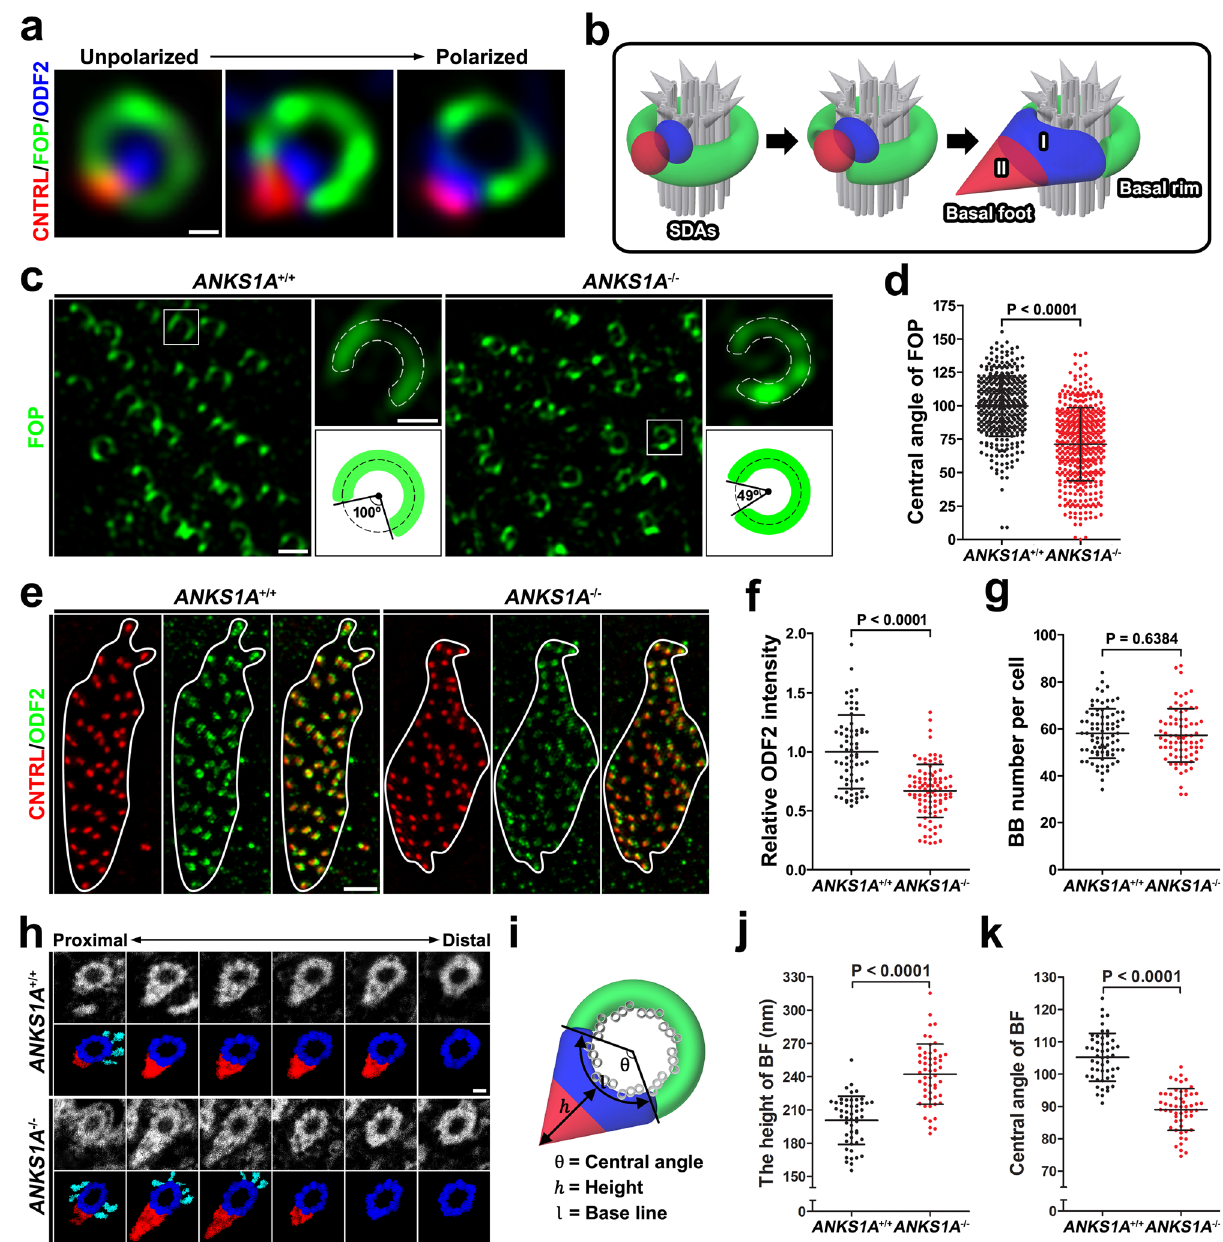
Fig. 2 ANKS1A loss results in partially impaired SDAs. a Representative 3DSIM images showing the gradual transition of SDAs from immature to the mature stage. Scale bar, 100nm. b Cartoon depiction elucidating the dynamic change of SDAs from an unpolarized to a polarized state. c 3DSIM images were obtained from the anterior – dorsal (AD) region of LWs, and the BB patches were then magni fi ed for further analysis. Schematic beside each panel is for the ×3.5 magni fi ed white box and depicts the central angle of the FOP-negative region. Scale bar, 500 nm. d Data in c were quanti fi ed. Data are depicted as mean± SD. Each point on the graph represents the central angle of the FOP-negative region. For the ANKS1A + / + group, n = 356 BBs from 3 mice; for ANKS1A − / − , n = 412 BBs from 3 mice. e Experiments were performed as described in c , except that CNTRL and ODF antibodies were used. The boundary of each BB patch is outlined in white. Scale bar, 2 μ m. f Data in e were quanti fi ed. Data are presented as mean± SD. Each point on the graph represents the relative level of ODF2 intensity per BB patch. For the ANKS1A + / + group, n = 68 cells from 2 mice; for ANKS1A − / − , n = 96 cells from 3 mice. g Number of BBs per cell was quanti fi ed based on their CNTRL staining, as illustrated in Supplementary Fig. 2c. Data represent mean ± SD. For the ANKS1A + / + set, n = 81 cells from 3 mice; for ANKS1A − / − , n = 77 cells from 3 mice. h A ribbon of consecutive sections (50nm) was placed on a one-hole grid and subsequently analyzed by TEM. Scale bar, 100 nm. i Schematic for clarifying the indices that represent the structural morphology of each BF. j , k The generated micrographs were aligned and used to measure the indices described in i . Data represent mean ± SD. For the ANKS1A + / + group, n = 51 BBs; for ANKS1A − / − , n = 54 BF angles clustered within 45° of the mean angle (black line), but p < 0.0001) than in the WT samples (CSD = 27°; n = 4937 BB this fell to 69% in KO samples (red line) (Fig. 4c). The circular from 234 cells, 4 mice) (Fig. 4c). standard deviation (CSD) of these BF angles (error bar on the To con fi rm the intracellular rotational polarity defects in graph) from the mean angle for each cell was much larger in ANKS1A KO mice, we used TEM to observe the BF protruding the KO samples (CSD = 58°; n = 5635 BB from 278 cells, 4 mice; laterally from the side of each BB. As expected, the BF positions